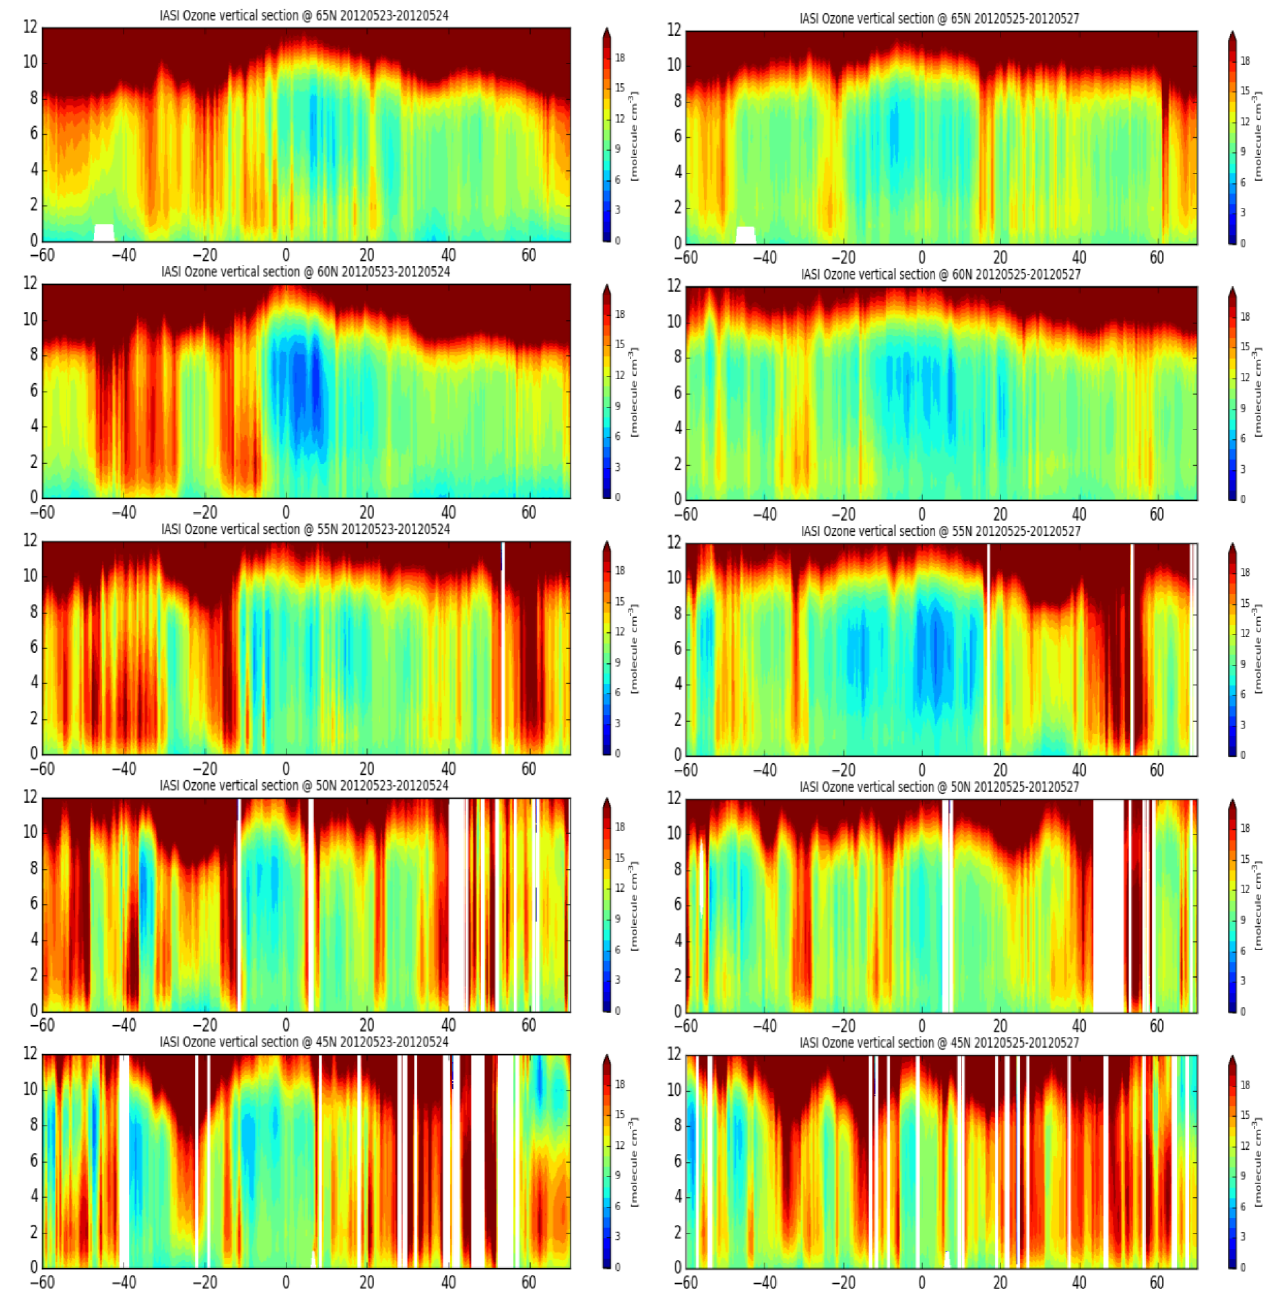
Figure 5. IASI vertical sections at various latitudes from 65 ◦ N (upper panel) to 45 ◦ N (lower panel) on 23–24 May 2012 (left column) and on 25–27 May 2012 (right